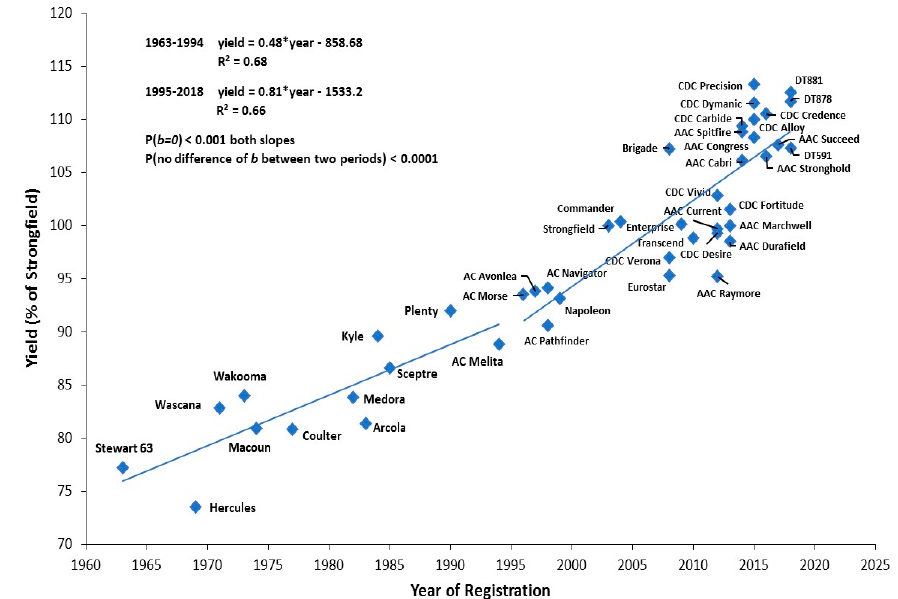
Figure 10. Grain yield (relative to the latest check cultivar AC Strongfield) and year of registration of Canadian durum wheat cultivars. Data are analyzed using a similar method described by Clarke et al. (2010).